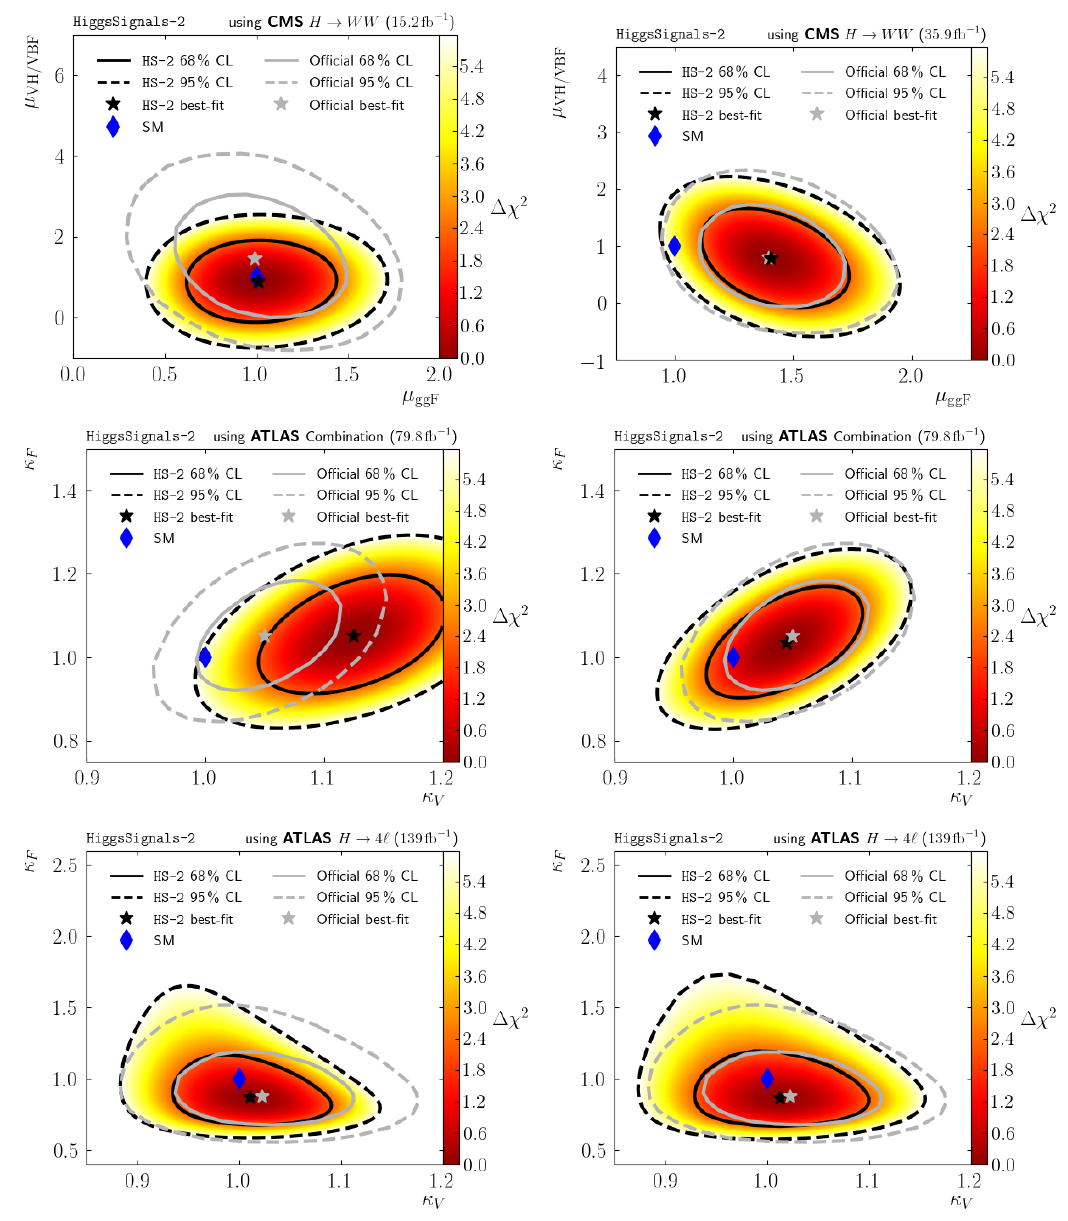
Figure 6: Constraints on Higgs boson production and couplings derived in [ 112 ] based on Higgs boson rate measurements in the H → WW decay from CMS [ 113 ] , [ 114 ] (top row) ; on combined STXS measurements from ATLAS [ 115 ] (middle row) ; and on the H → 4 (cid:96) decay from ATLAS [ 116 ] (bottom row) . In the top and middle rows, improving the input to the approximate likelihood reconstruction (right panels) improves the deficiencies seen when necessary information is omitted (left panels) . In the bottom row, even the most complete available input still yields deviations between the ATLAS results and the reconstruction of the likelihood, which cannot be described by the publication of results in formats like STXS cross section values and uncertainties. Instead, a more complete representation of the likelihood is required. See text for